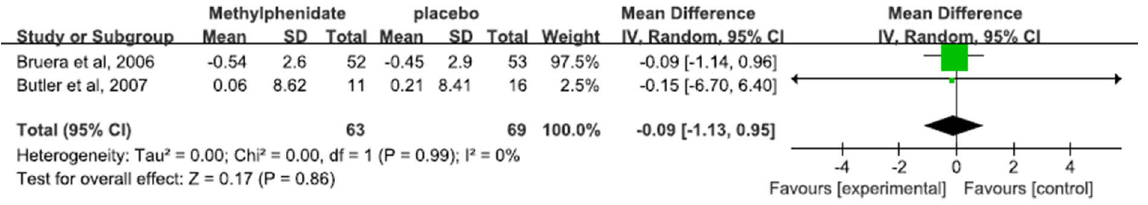
Figure 4. Effect of Methylphenidate on depression associated with CRF.